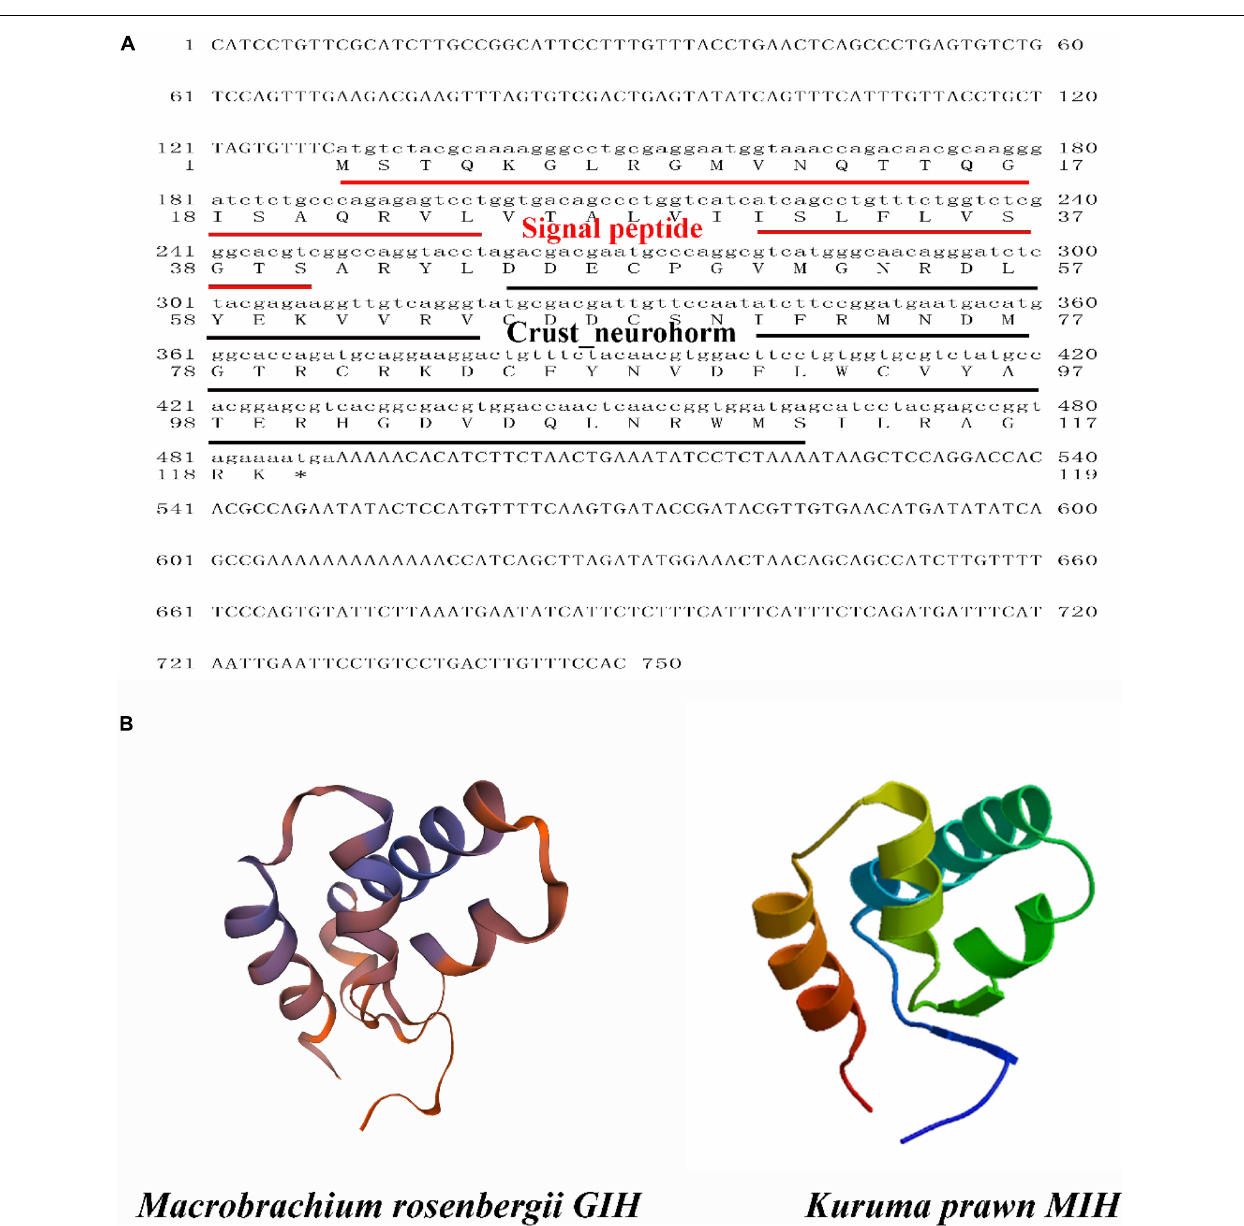
FIGURE 1 | The sequence analysis of Mr GIH. (A) The full-length ORF nucleotide sequence and deduced amino acid sequence of Mr GIH. Signal peptide was underlined in red lines. Crustacean neurohormone was underlined in black lines. (B) Protein structural homology of Mr GIH was modeled by SWISS-MODEL service, which built a high quality of 3D model with kuruma prawn MIH